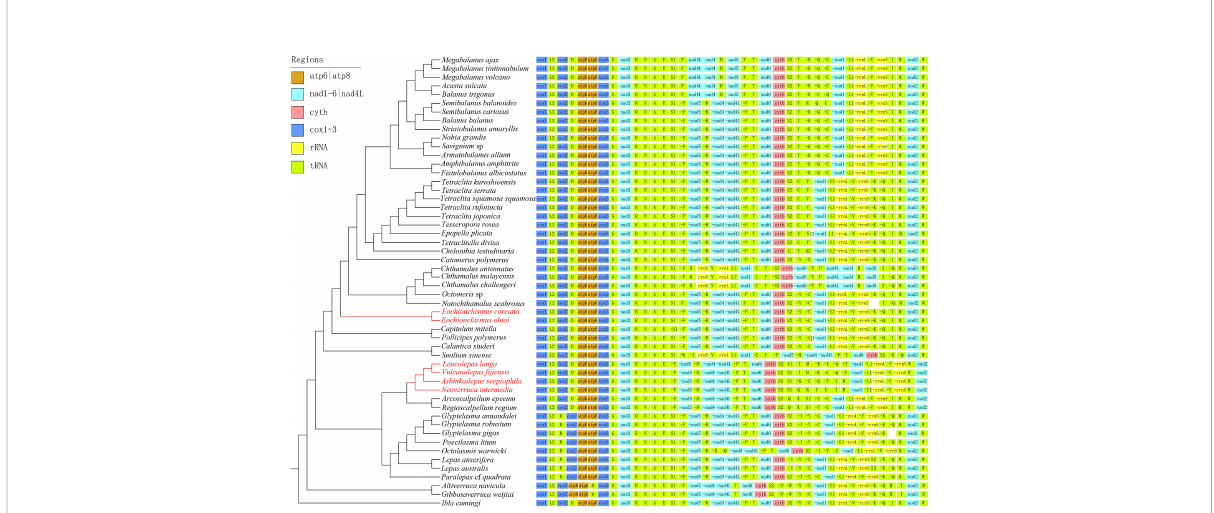
FIGURE 3 Mitogenomic gene arrangement patterns of barnacles superimposed on the phylogenetic tree. Genes encoded by the light-strand are initiated by a “ - ” . The symbol “ a ” represents the heavy-strand gene block “ S2 – C – Y ” , while “ b ” represent the light-strand gene block “ C – C ”